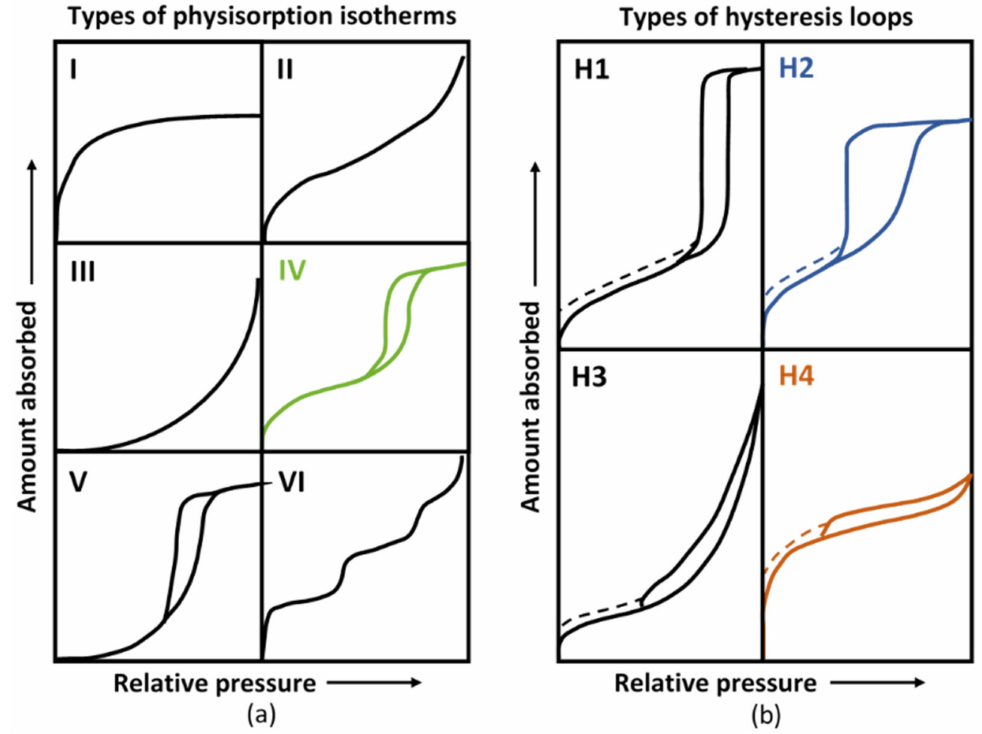
Figure 12. Types of physisorption isotherms ( a ) and hysteresis loops ( b ) (after Sing